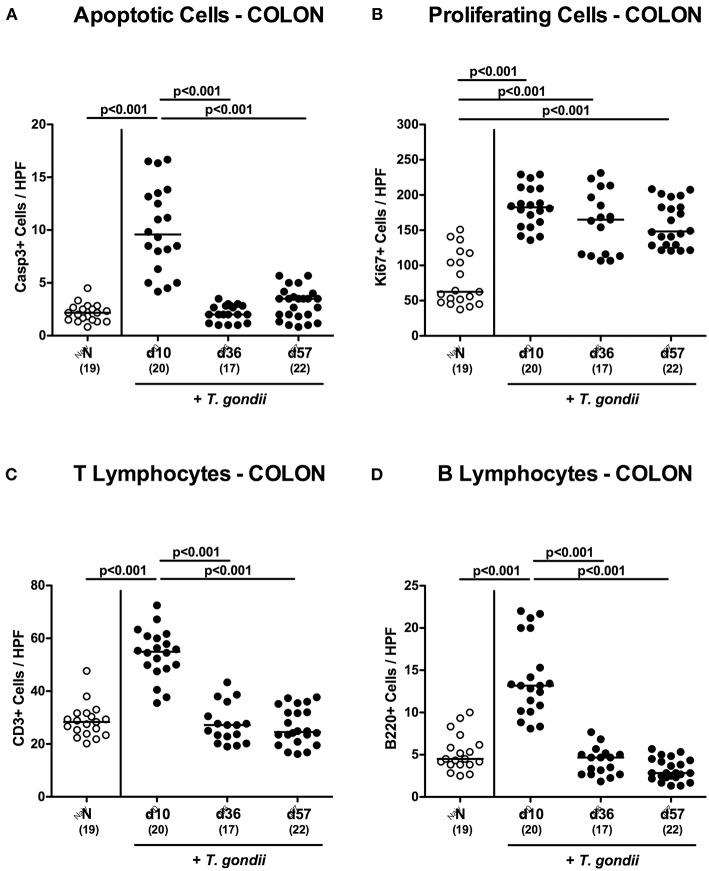
Microscopic inflammatory sequelae in the colon over time following peroral low-dose T. gondii infection. Mice were perorally infected with one cyst of T. gondii on day 0 and surveyed at days (d) 10, 36, and 57 post-infection (p.i.; closed circles). Naive (N) mice served as uninfected controls (open circles). Out of six representative high power fields (HPF, 400x magnification) per animal the average numbers of (A) apoptotic (casapse3+, Casp3+) and (B) proliferating (Ki67+) colonic epithelial cells as well as of (C) T lymphocytes (CD3+) and (D) B lymphocytes within the colonic mucosa and lamina propria were assessed in immunohistochemically stained large intestinal paraffin sections. Medians (black bars), levels of significance (p-values) as determined by one-way ANOVA test followed by Tukey post-correction for multiple comparisons and numbers of analyzed mice (in parentheses) are indicated. Data were pooled from four independent experiments.